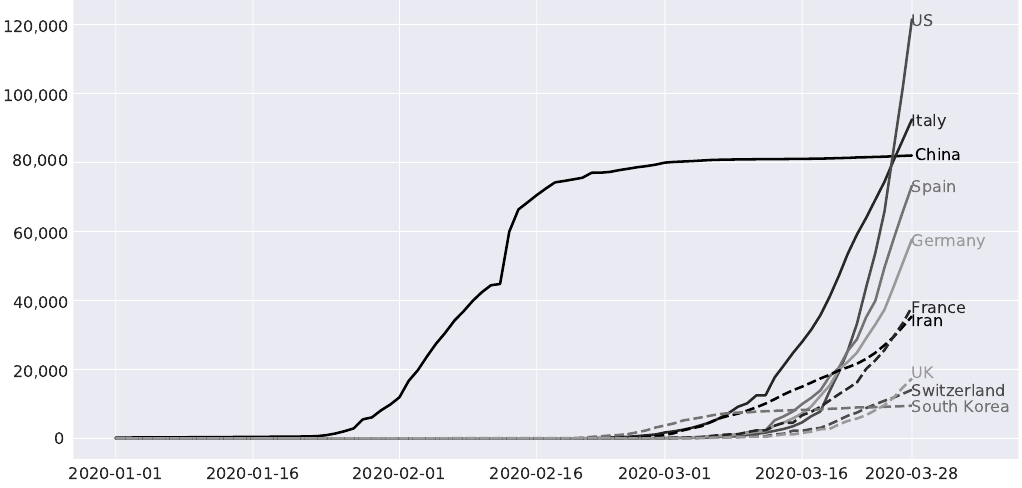
Figure 3. Number of confirmed COVID-19 cases for the 10 most affected countries United States (US),